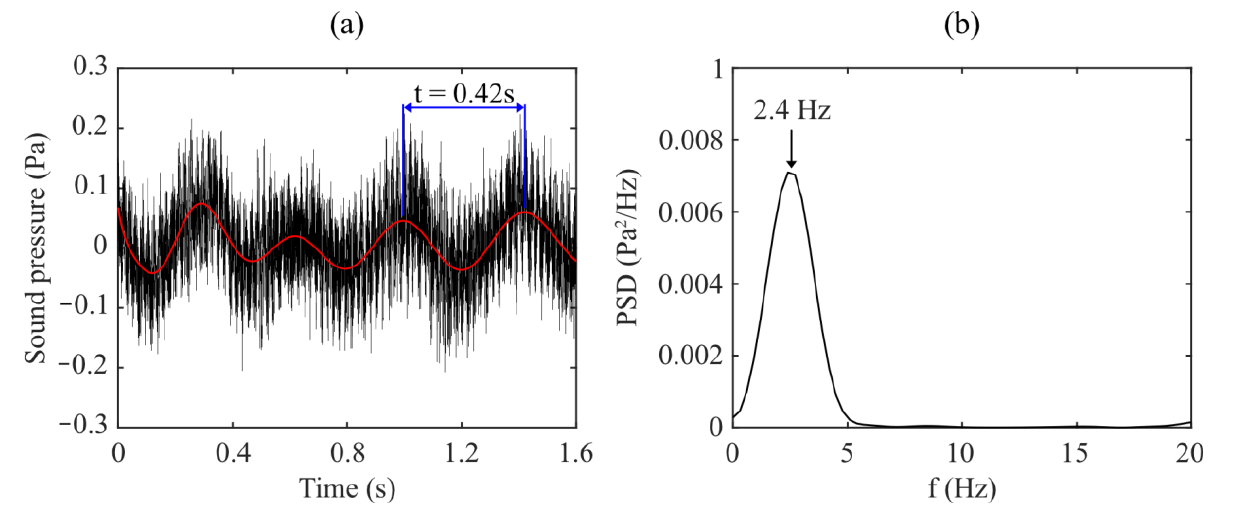
Figure 14. ( a ) The time history of the sound pressure from experimental results. ( b ) The PSD of the sound pressure at the microphone M1 upstream of the fan.